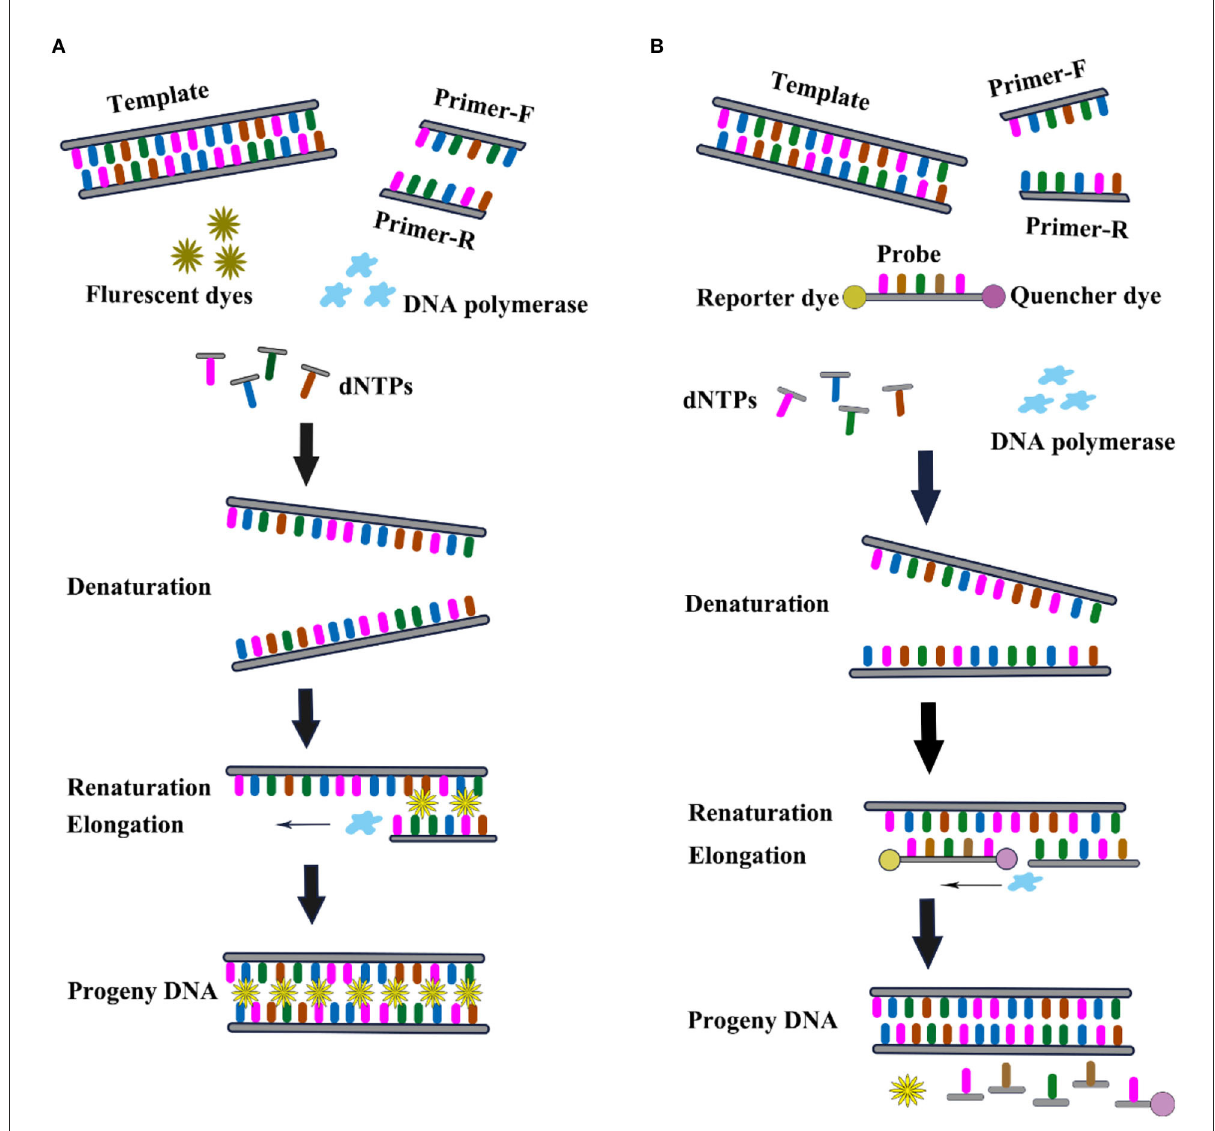
FIGURE9 Schematic diagram of real time qRT-PCR. (A) NDV SYBR Green I assay. (B) NDV TaqMan